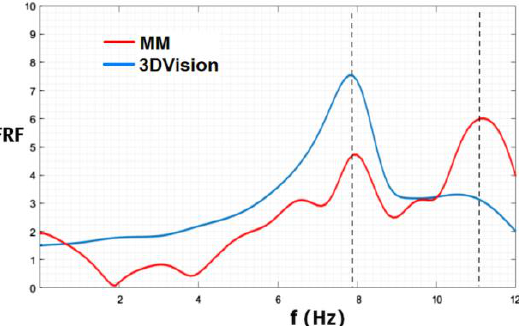
Figure 3. FRF magnitude by the MM technique (red line) and by 3DVision markers data (blue line).